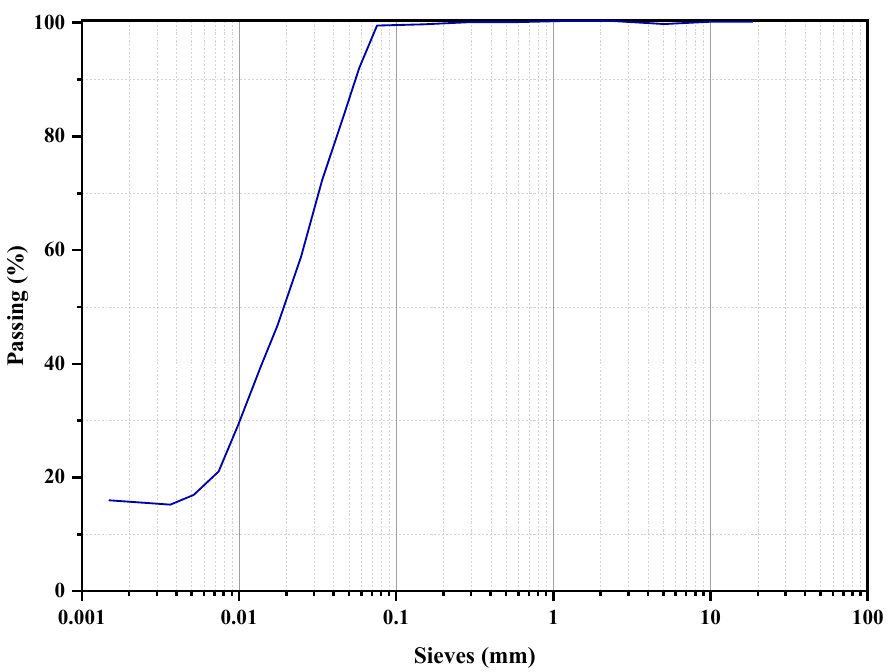
Figure 3. Particle size distribution of RHA. Table 2. Physical characteristics of aggregates.